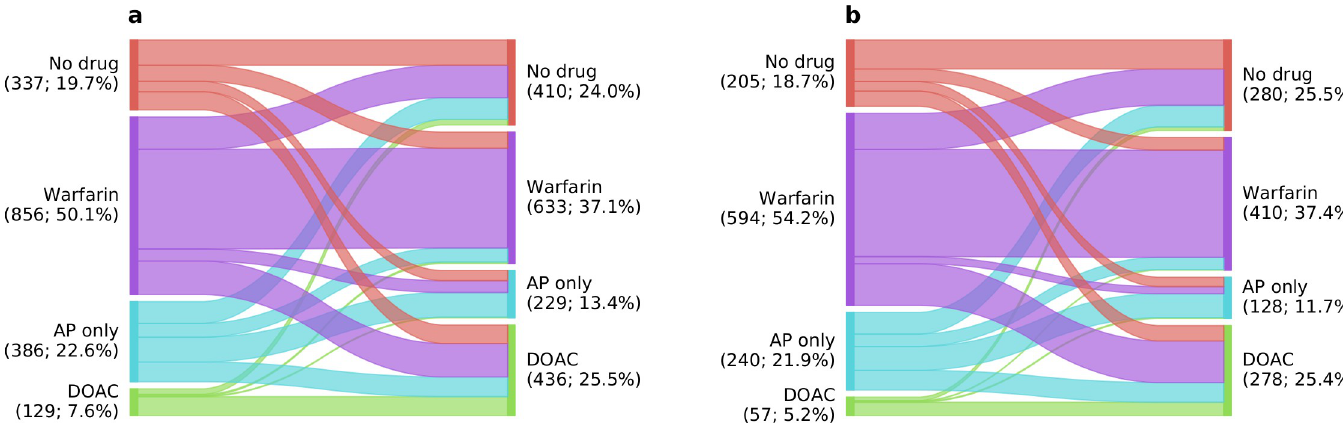
Fig 4. Medication switching in patients with CHA 2 DS 2 -VASc � 2 at last visit. a) all visits at least 12 months apart and b) last visit before vs last visit after the 2014 NICE guideline update (b is a subset of a). Line width indicates overall proportion.